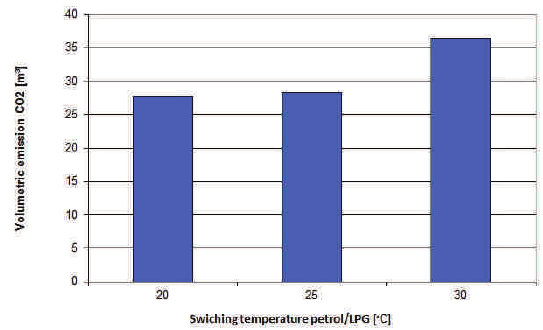
Fig. 4. Changes in the composition of toxic constituents and oxygen in the exhaust fumes during warm-up phase for engine at idle